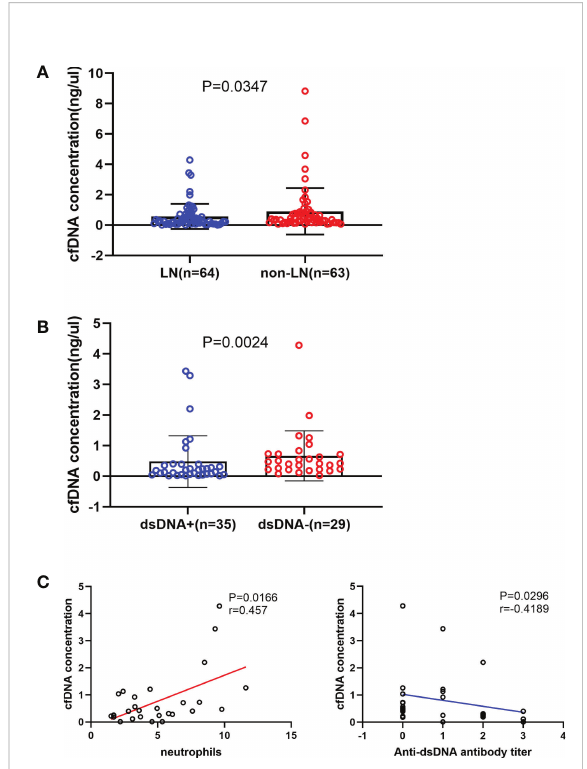
FIGURE 1 Relationship between the cell-free DNA (cfDNA) concentration and the severity of systemic lupus erythematosus. (A) The cfDNA concentration was signi fi cantly lower in the LN (n = 64) group than in the non-LN (n = 63) group (0.257 [0.107-0.61] ng/µL vs 0.406 [0.178-0.818] ng/µL; P = 0.035). (B) LN patients with anti- double-stranded (ds) DNA antibodies (n = 35) had a signi fi cantly lower cfDNA concentration than those without anti-dsDNA antibodies (n = 29; 0.188 [0.051-0.393] ng/ m L vs 0.422 [0.218- 0.731] ng/ m L, P =0.0024). (C) The cfDNA concentration increased with increased neutrophil counts ( r =0.457, P =0.0166) and decreased with increased anti-dsDNA antibodies titre in LN group ( r =-0.4189, P